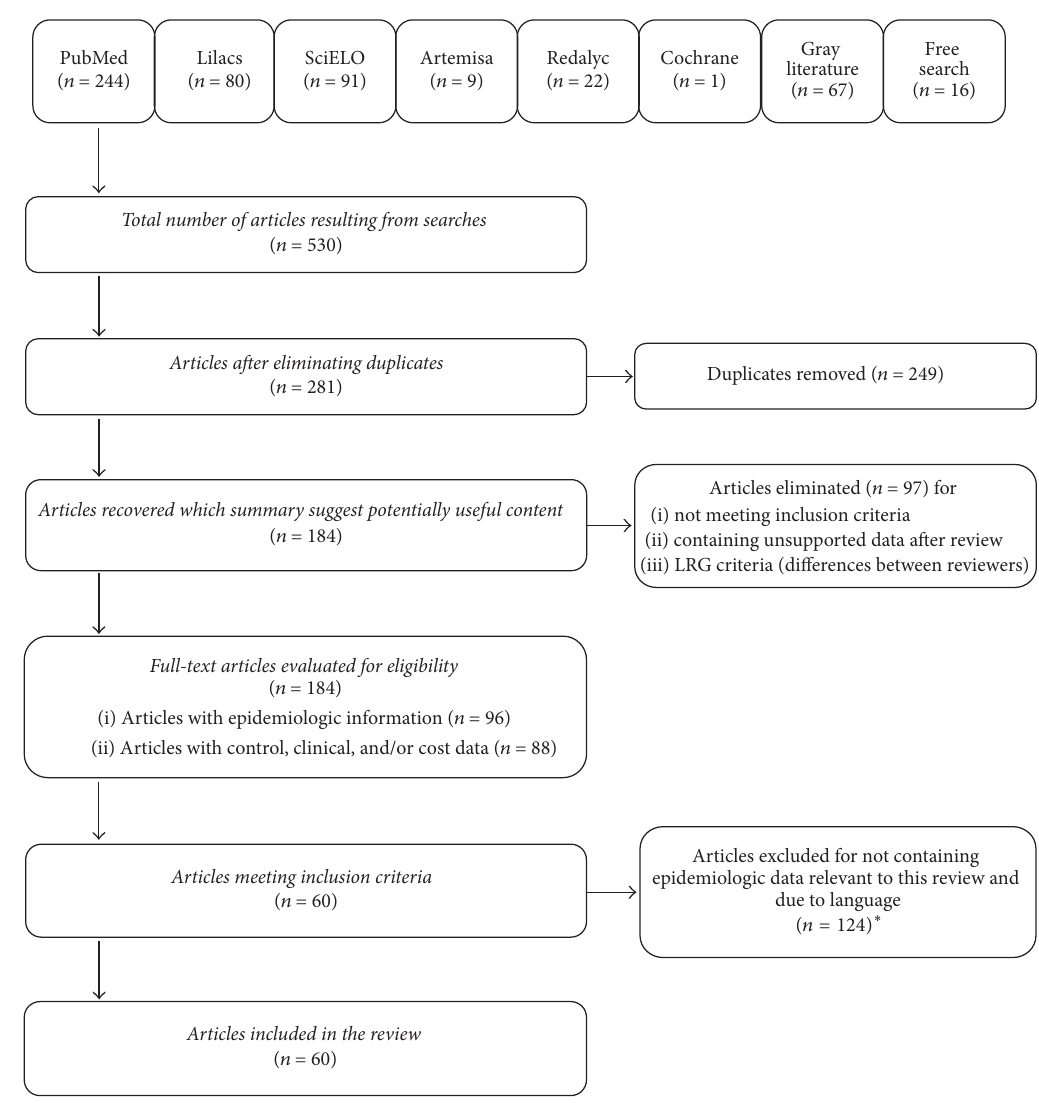
Figure 1: Flow diagram outlining the search strategy of the systematic review of dengue in Latin America, 2000–2013. ∗ Articles eliminated because they did not contain any dengue-related data relevant to this review ( 𝑛 = 122 ) or were written in a language other than English or Spanish ( 𝑛 = 2